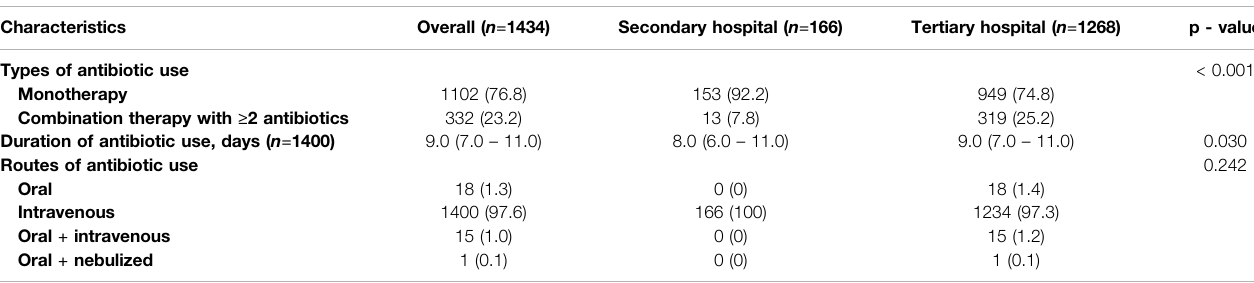
TABLE 2 | Antibiotic using characteristics of included AECOPD patients receiving antibiotic